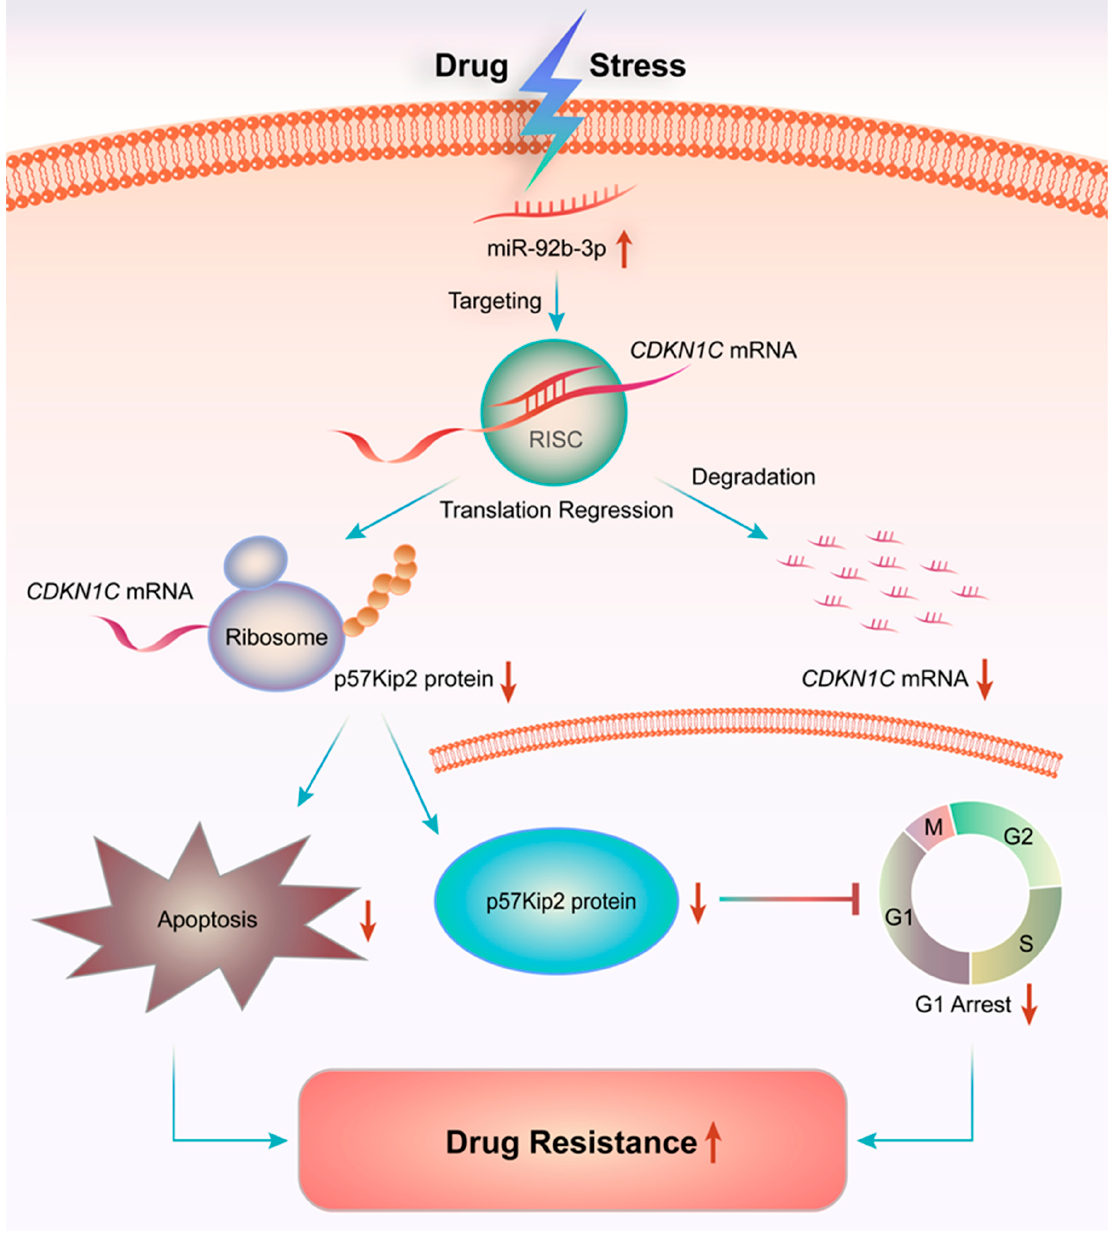
Figure 8. miR-92b-3p regulates chemotherapeutic drug resistance by targeting CDKN1C . Chemotherapeutic agents such as PTX could up-regulate the expression of miR-92b-3p, thereby inhibiting the expression of target gene CDKN1C , reducing cell cycle G1 arrest and apoptosis in chemotherapy, which promotes the increase of cell tolerance to chemotherapy drugs and multidrug resistance.